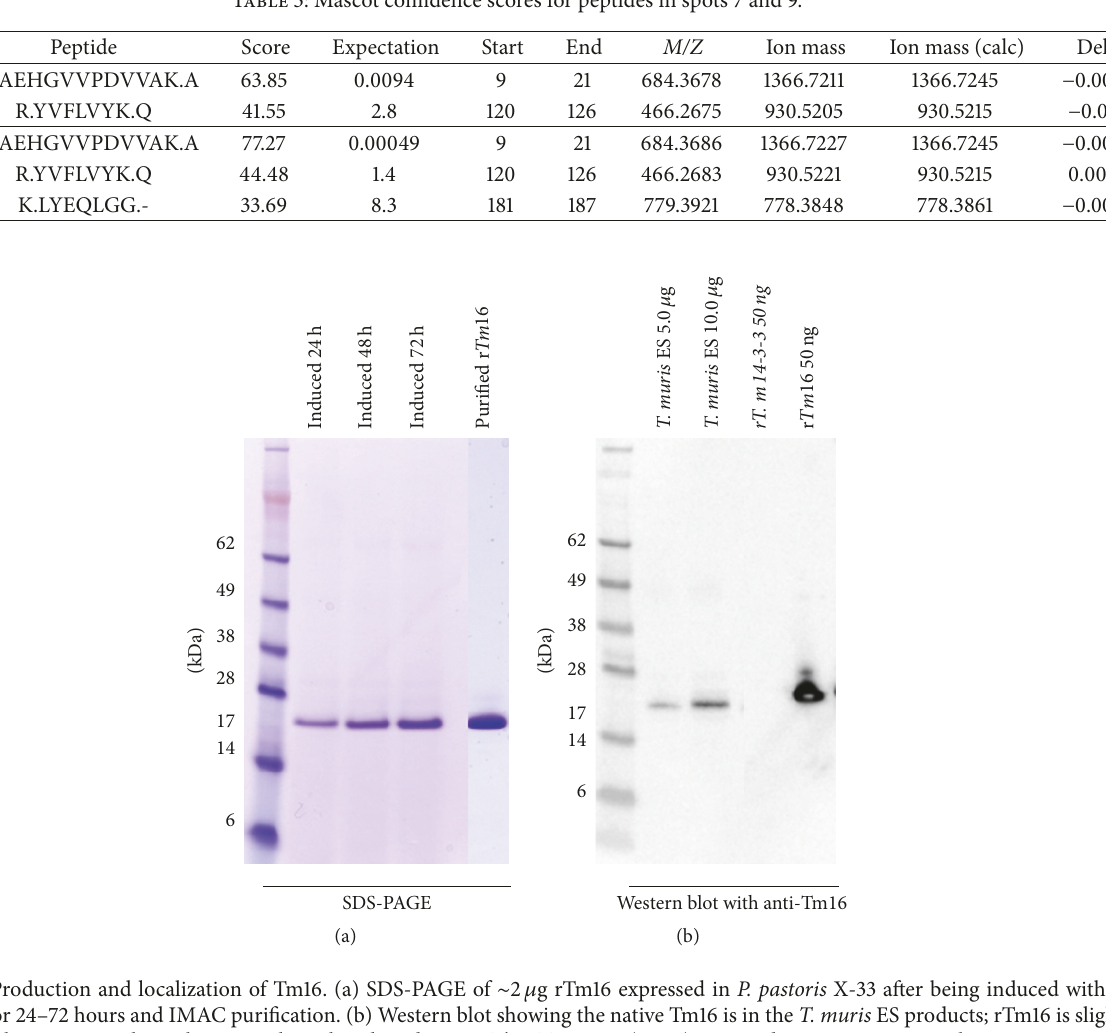
Table 3: Mascot confidence scores for peptides in spots 7 and 9.